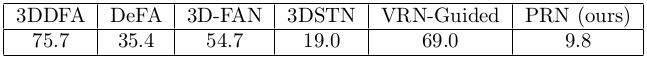
Table from the paper: Joint 3D Face Reconstruction and Dense Alignment with Position Map Regression Network
Table text:
3DDFA
DeFA
3D-FAN
3DSTN
VRN-Guided
PRN(ours)
75.7
35.4
54.7
19.0
69.0
9.8